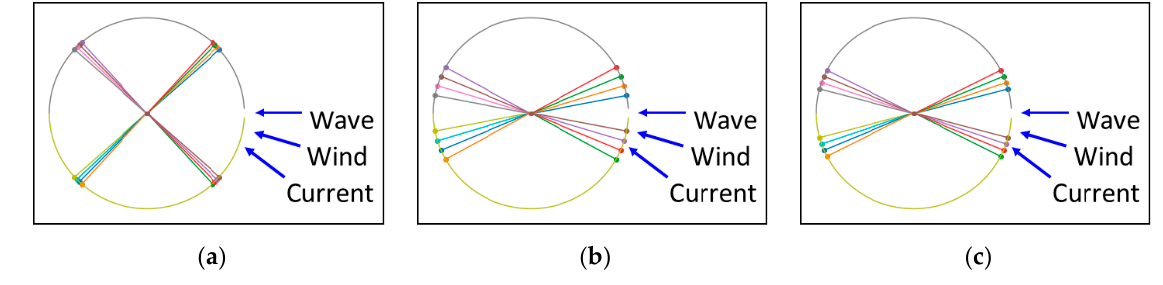
Figure 10. Mooring configurations. ( a ) Human experts. ( b ) BOA. ( c ) ANN based